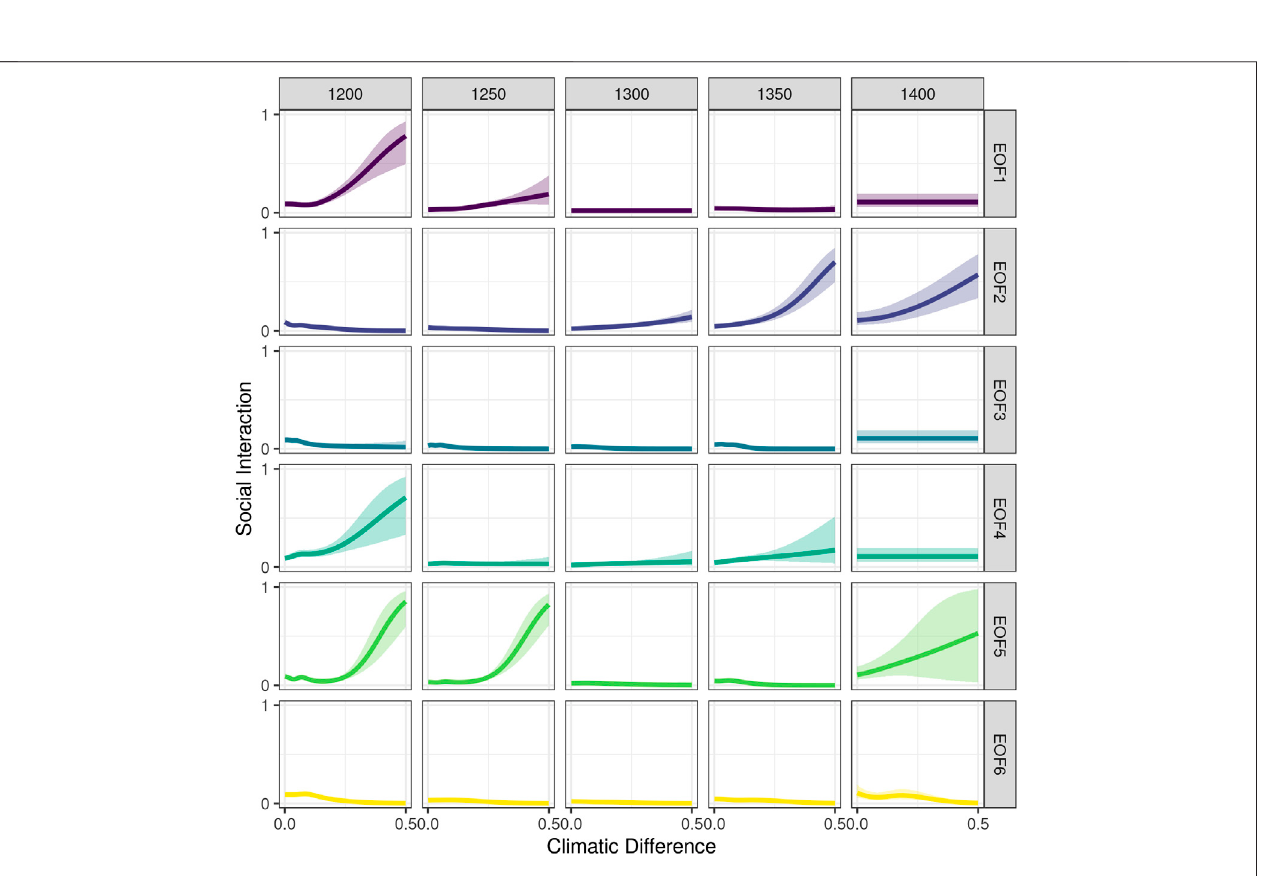
Frontiers in Earth Science |